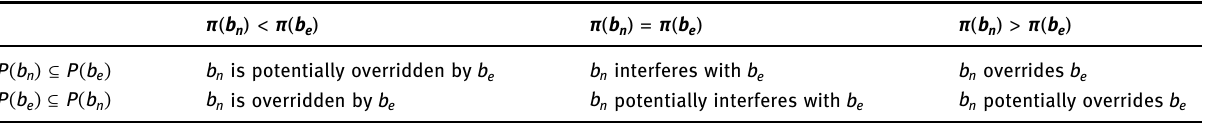
Table 1: Behaviour Checker feedback for di ff erent con fl icts